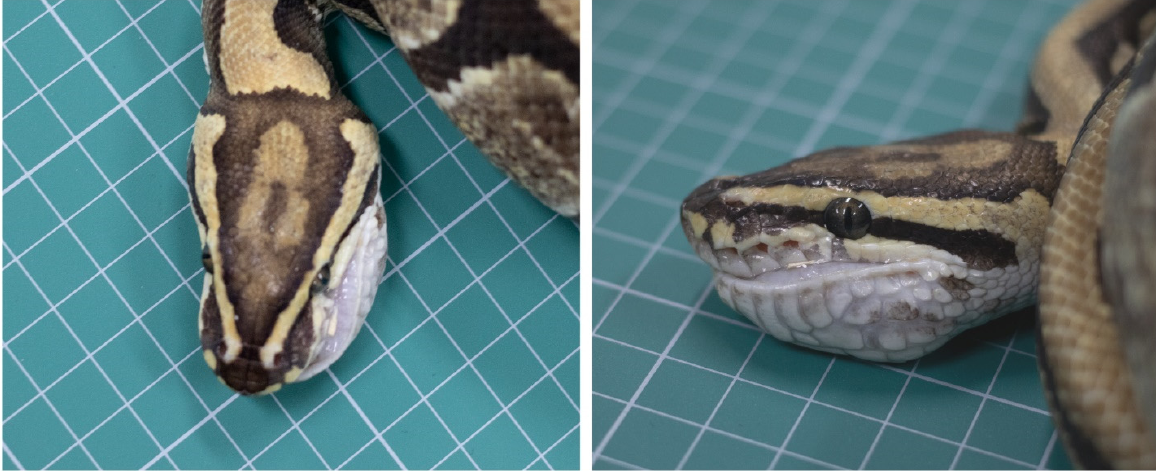
Figure 1. Clinical examination of the snake revealed a 2 × 3.5 cm-sized mass in the left submandibular region.